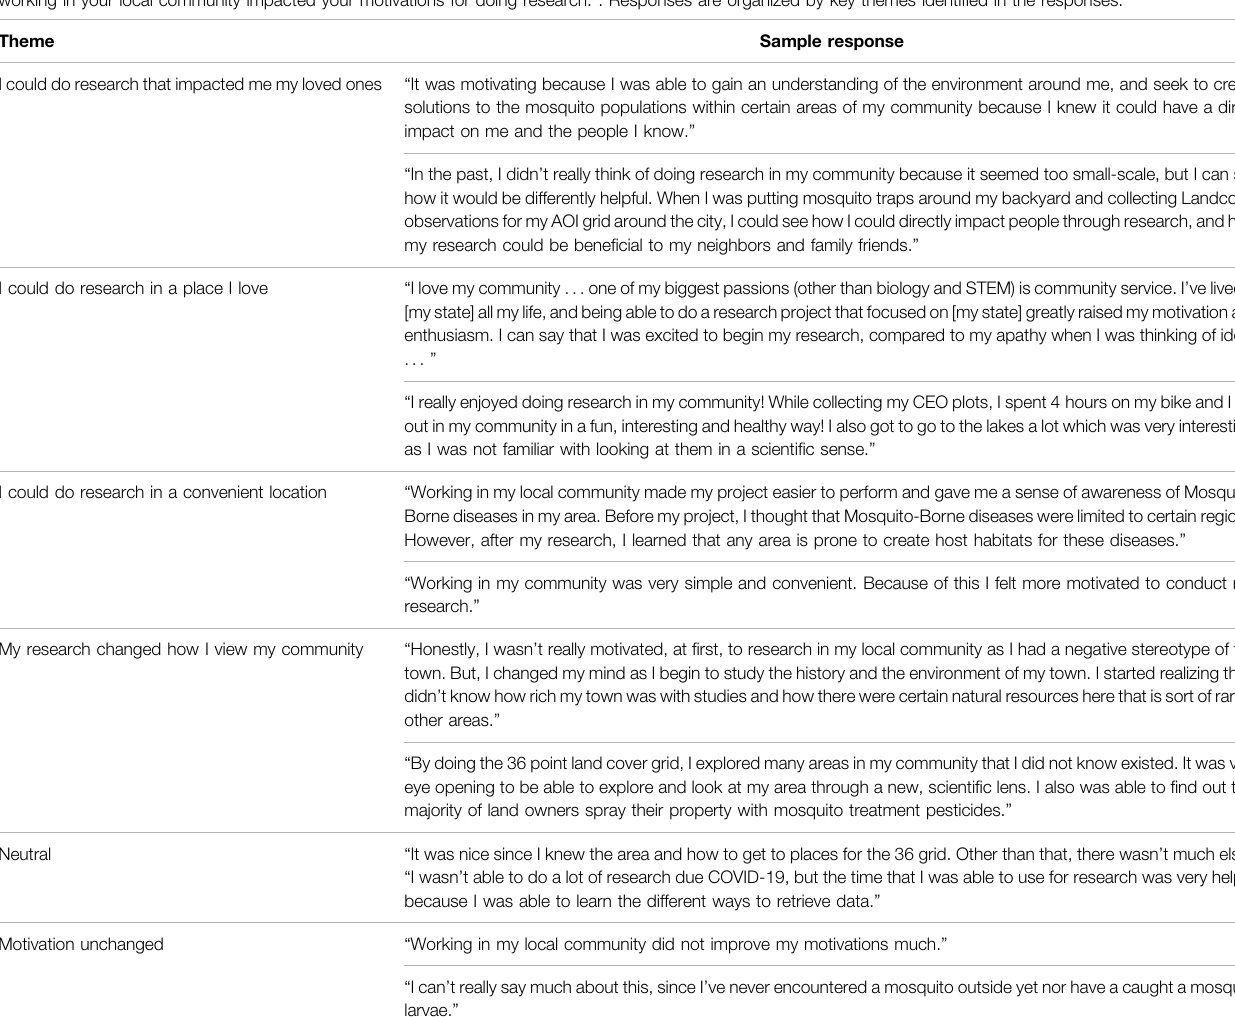
TABLE 2 | Sample responses from interns for the survey question “ We encouraged you to perform your research in your local community, please describe how, if at all, working in your local community impacted your motivations for doing research. “ . Responses are organized by key themes identi fi ed in the responses. Theme Sample